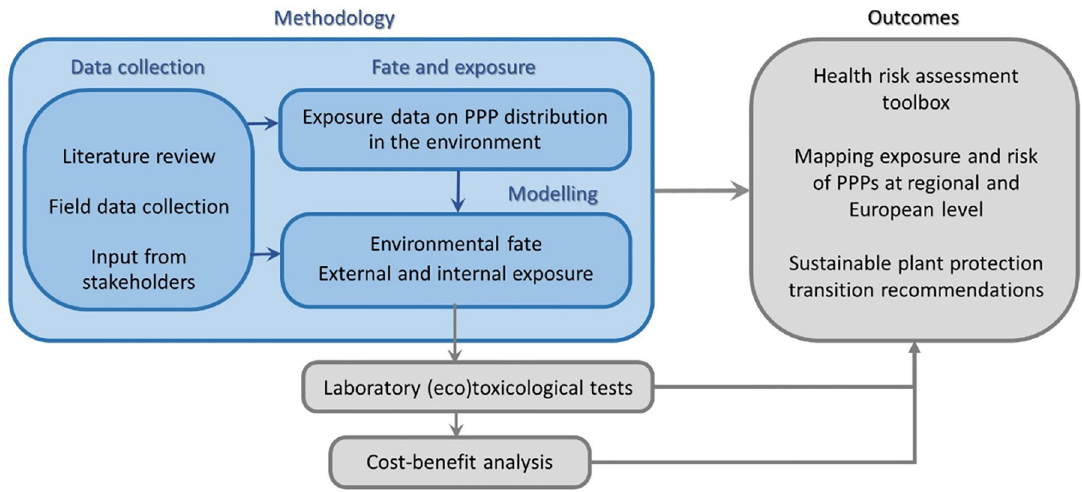
Fig 1. Schematic representation of SPRINT work organization. Only the activities in blue boxes represent field related activities covered in this study protocol.